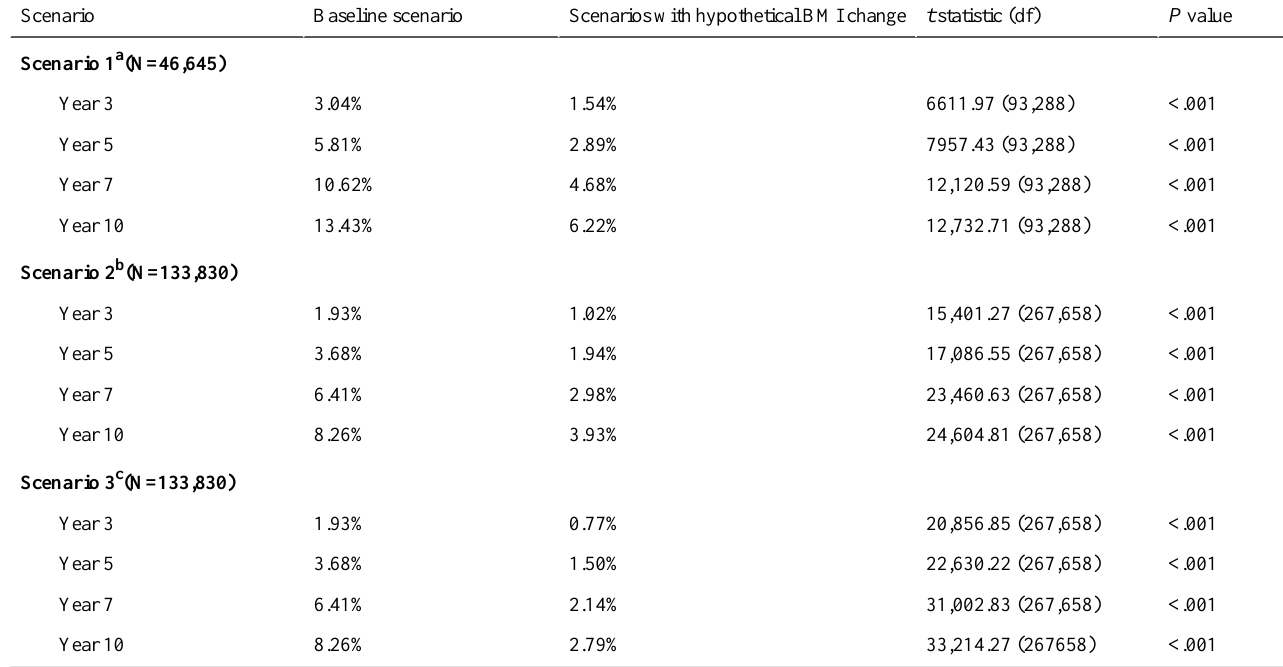
Table 2. Model-predicted probability of diabetes onset in three scenarios compared with their respective status quo